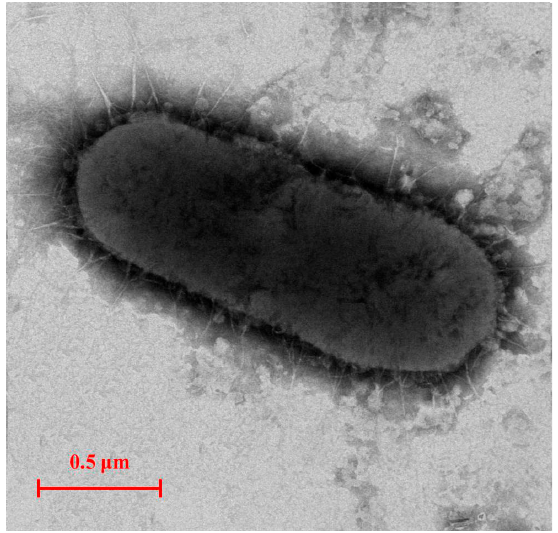
Figure 1. Transmission electron micrograph image of strain E2S (×8000, Zoom-1 HC-1, 80 kV).